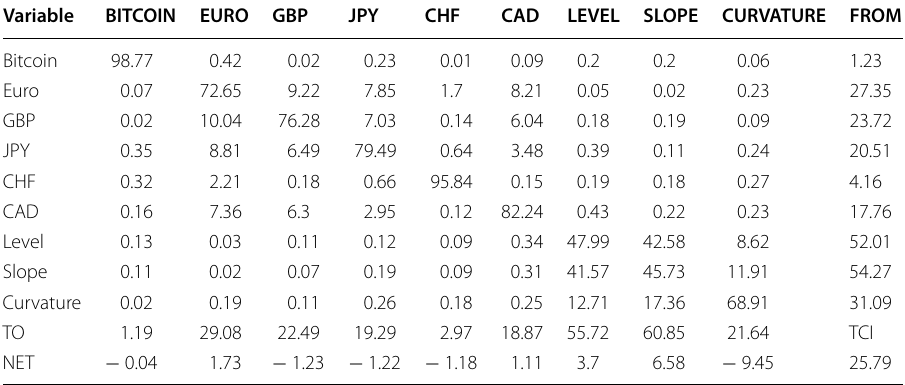
Table 3 Static connectedness of the volatility of the exchange rates and components of the yield